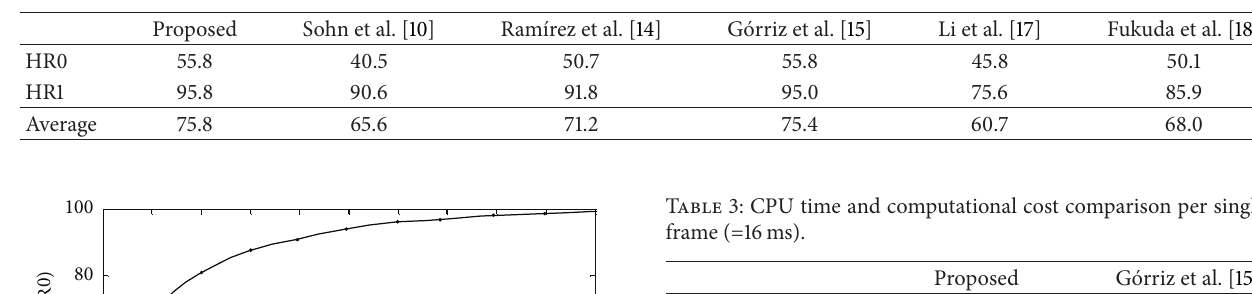
Table 2: Comparison of the proposed algorithm to conventional algorithm in the frame based speech and nonspeech discrimination test for SNRs from clean to − 5 dB in terms of average HR0 and HR1.